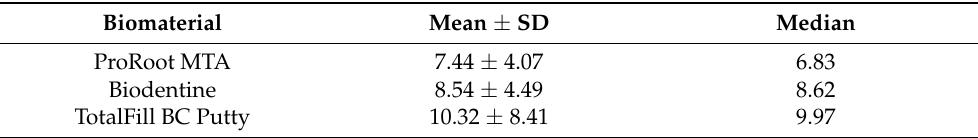
Figure 3. Box-plot of push-out bond strength distribution within each experimental group, according to both biomaterial and condition (presence or absence of blood contamination). Table 2. Push-out bond strength descriptive statistics for each biomaterial regardless of blood contamination (MPa).